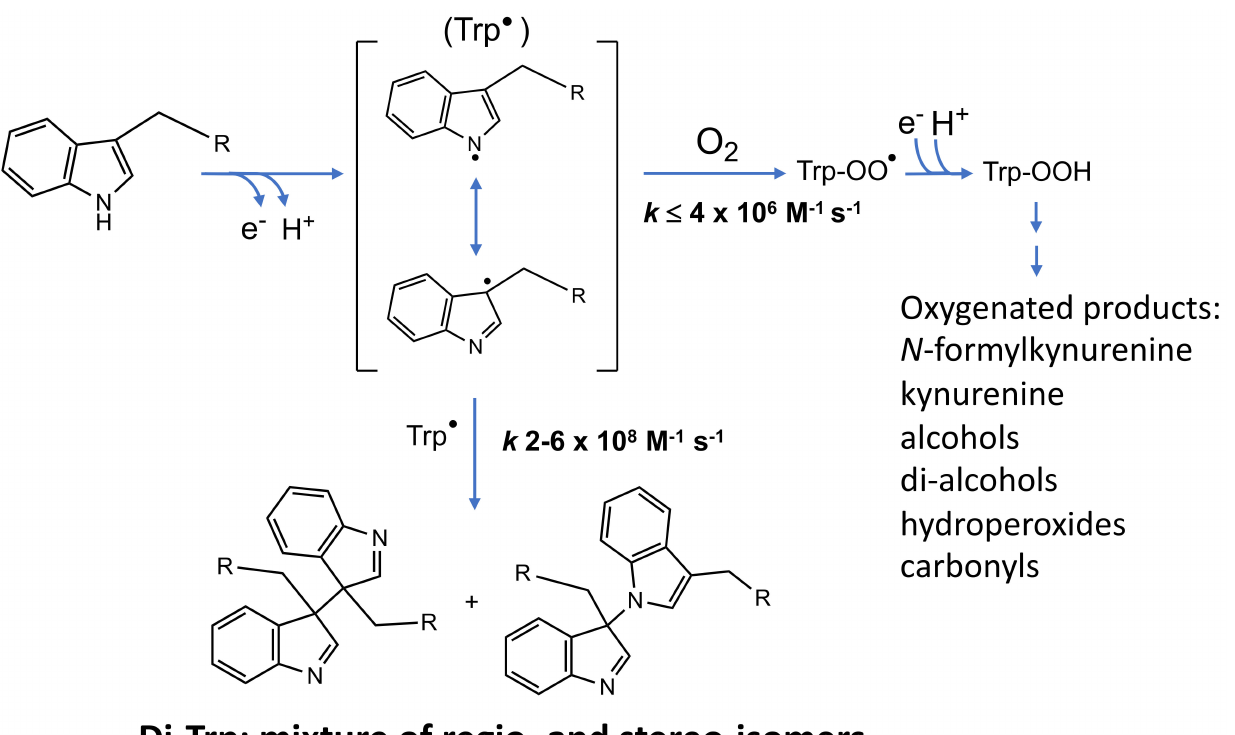
Figure 6. Formation and reactions of Trp indolyl radicals (Trp • ). Self-reactions of Trp • produce carbon– carbon (C3–C3) and carbon–nitrogen (C3–N1) di-Trp crosslinks. It should be noted that multiple stereoisomers are potentially formed for both di-Trp dimers. Kinetic constants for self-reactions